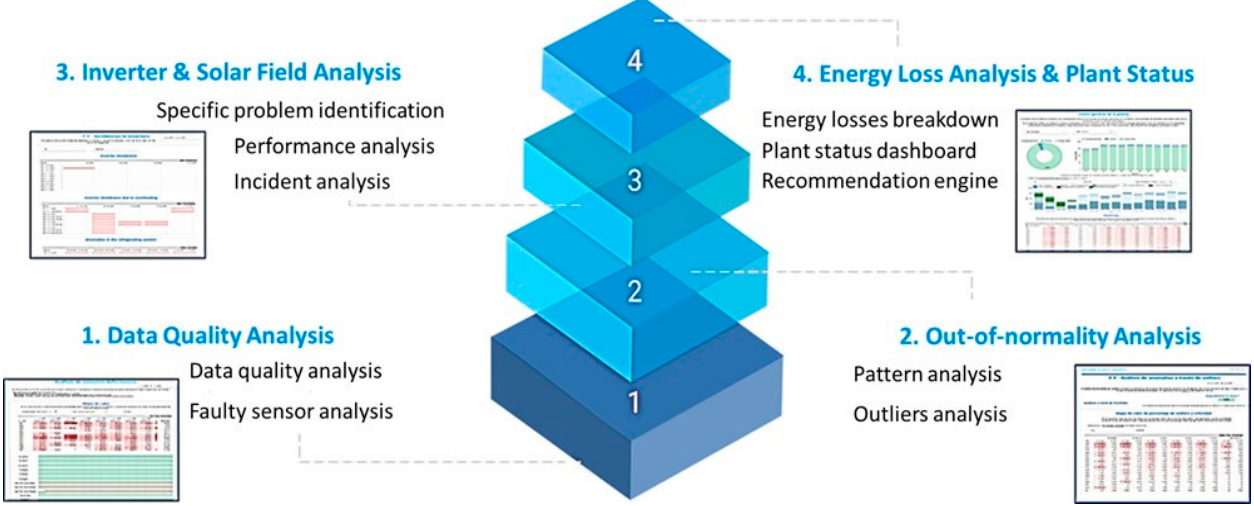
Figure 1. Layered description of the proposed cloud-based platform architecture for assets diagno- sis and O&M in PV systems.